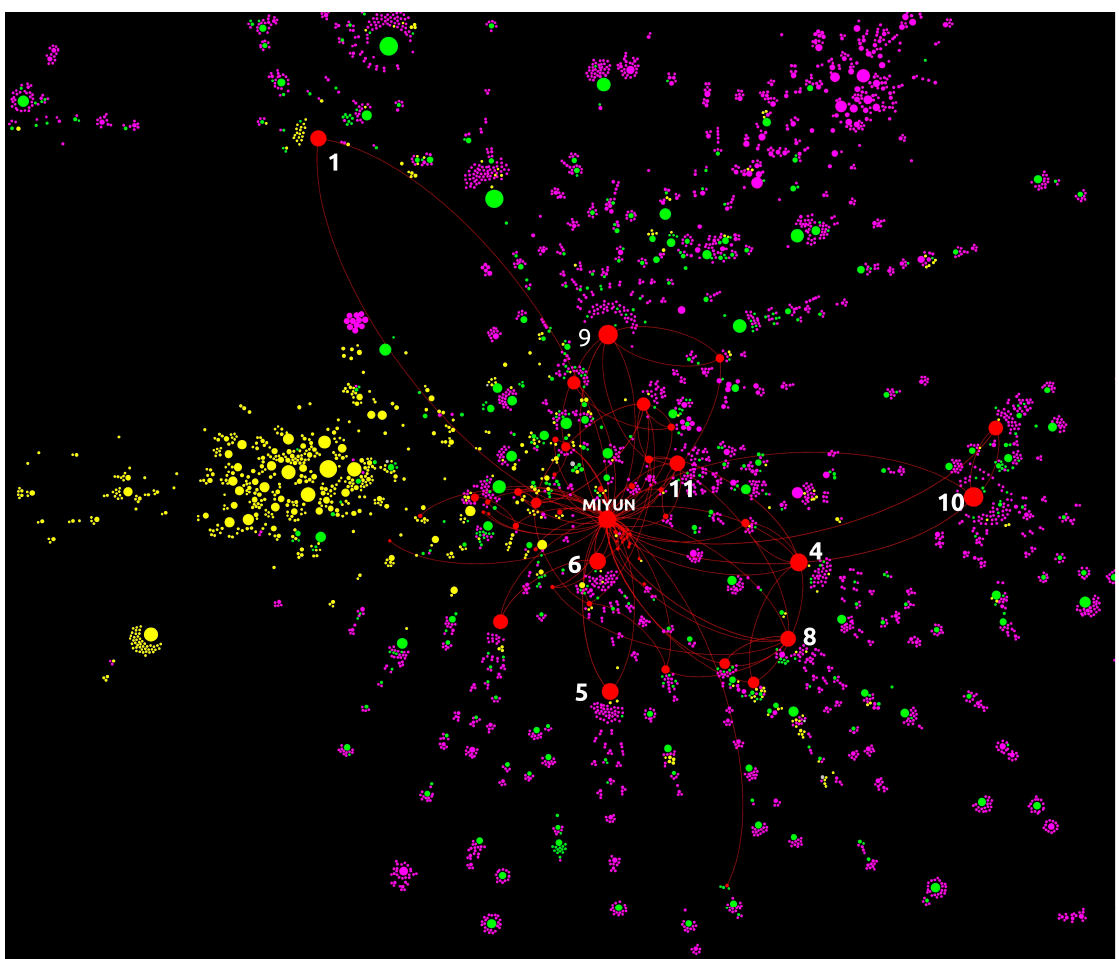
Figure 4. Red nodes: 1 st degree ego-network of Miyun. Numbered are (some of) his main students (numbers refer to Table 1 below). Yellow nodes: actors born and died in the Ming. Green nodes: born in the Ming and died in the Qing. Magenta nodes: born and died in the Qing.